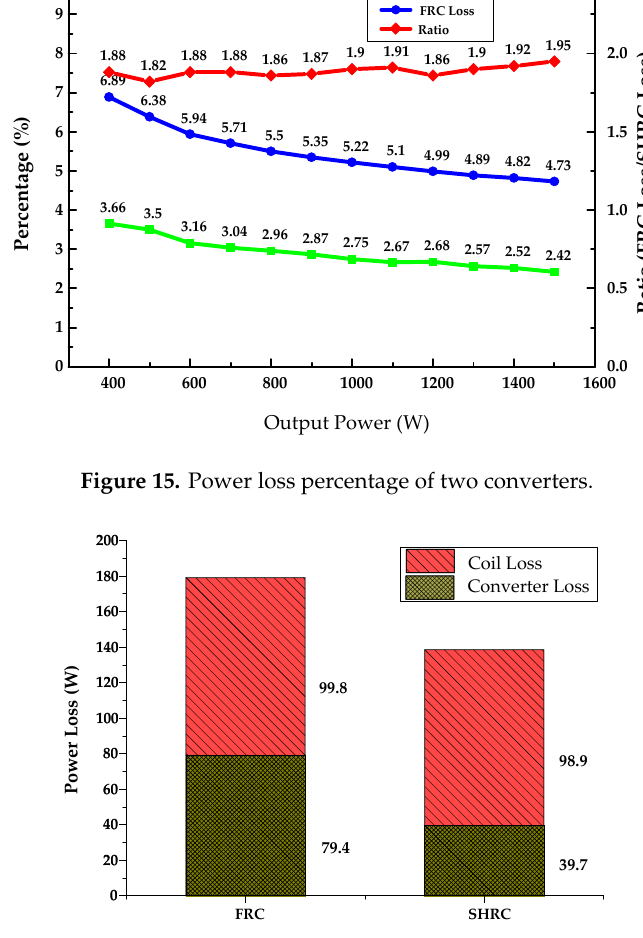
Figure 16. Power loss distributions for the two converter-based IPT systems.